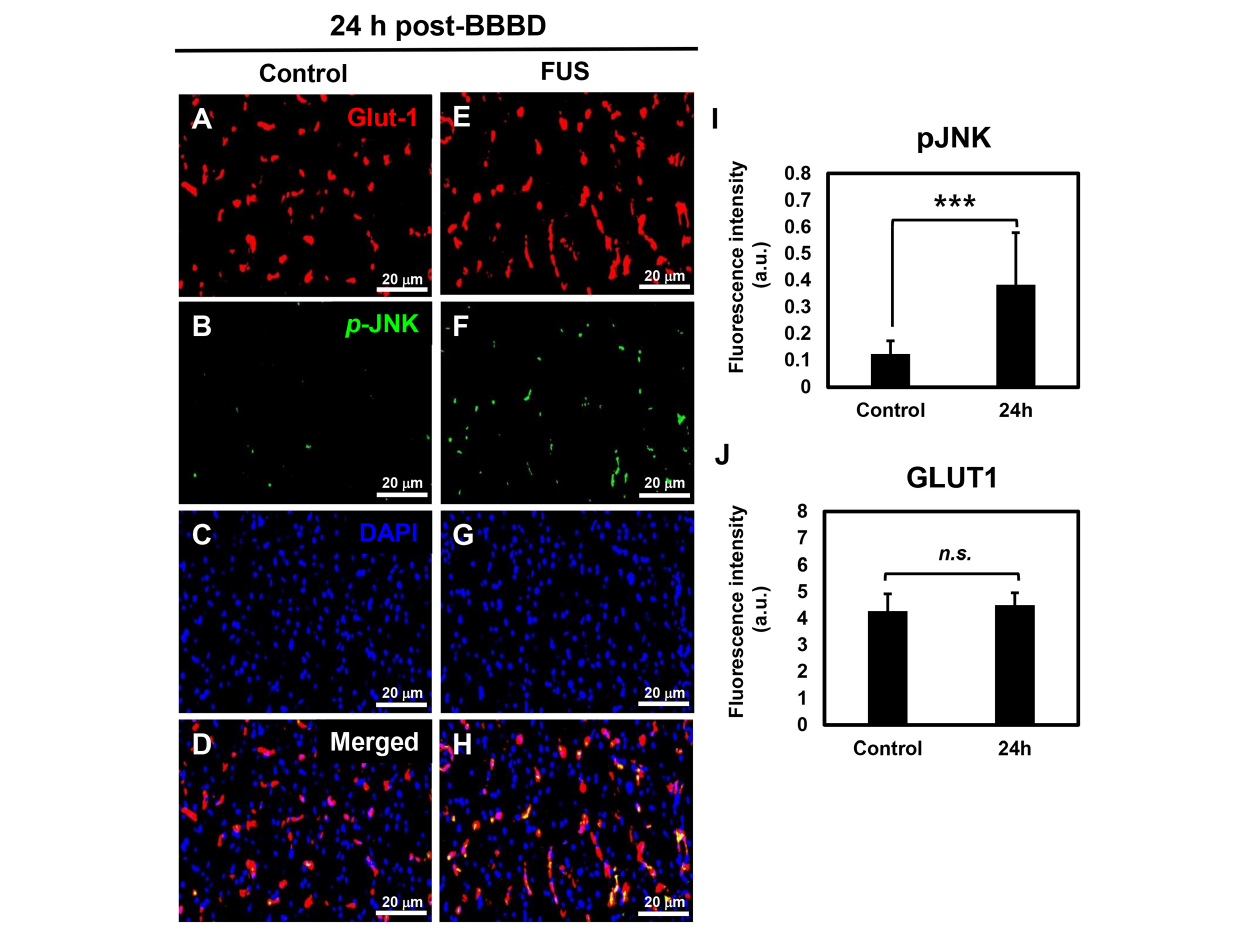
FIGURE 5 | JNK activation in vascular endothelium at 24 h post-BBBD. Immunofluorescence images were collected from the control hemisphere (A–D) and FUS (E–H) hemispheres at 24 h post-BBBD. Glut1 (red) was used as a vascular endothelial marker. The fluorescence intensities were calculated from 15 ROIs per hemisphere in three sections (I,J) . Data are presented as the mean ± SD, ∗∗∗ P < 0.001). Scale bar was represented 20 µ